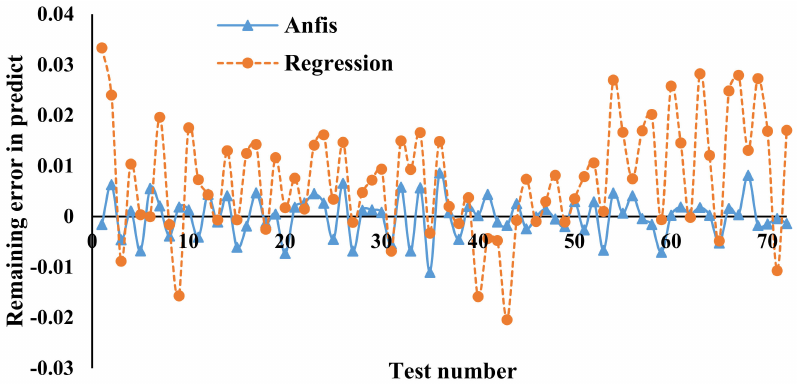
Figure 9. Deviation distance of predicted values of ANFIS and regression models from measured